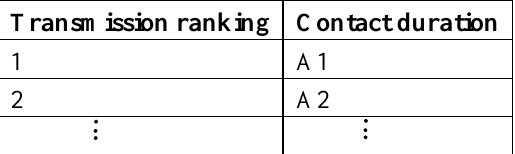
Table 2. The contact table of a sensor node.